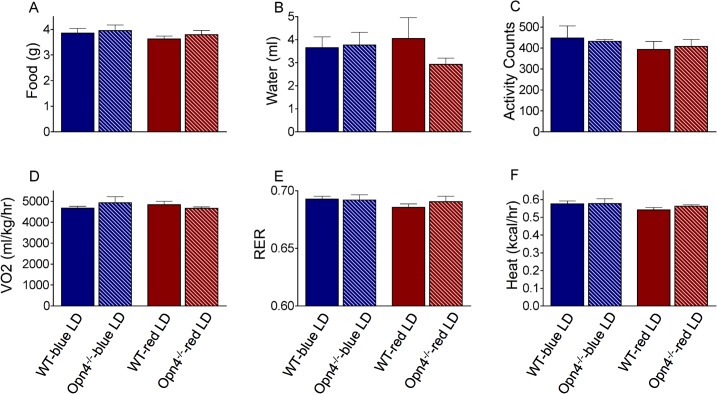
The extreme weight loss profile in Opn4
-/- mice could not be attributed to any gross-metabolic changes that occur early during the ketogenic diet—blue or red LD challenge.Solid bars stand for WT animals, striped bars stand for Opn4
-/- mice. Bars are also color-coded: blue stands for blue LD, red stands for red LD. All mice were fed ad libitum ketogenic diet during the course of the experiment (n = 4 mice / group). All groups, regardless of their genotype and the light conditions they were in, consumed similar amounts of food (A) and water (B) (t-tests: p>0.05). Activity was measured as infrared beam crossings and expressed as number of counts per 15 minute intervals. C) Activity levels were similar in all groups (t-test: p>0.05). There were no significant differences between groups in metabolic parameters such as oxygen consumption (D) and respiratory exchange rate (RER) (E). Respiratory exchange rate was calculated for each animal by taking the carbon dioxide production / oxygen consumption ratio. F) Heat production also did not differ significantly between groups. All values represent group means with ±SEM. (Under red and blue LD cycle: Opn4
-/- n = 4, WT n = 4)